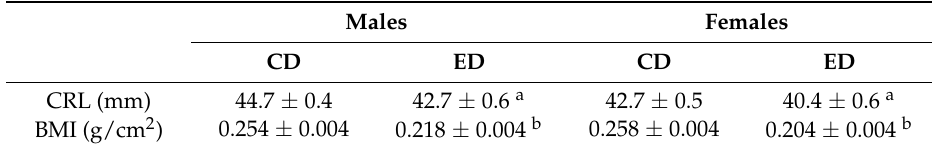
Figure 2. Relationship between fetal outcome and maternal plasma levels of ( A ) Arachidonic acid (ARA) and ( B ) Docosahexaenoic acid (DHA) in experimental diet fed dams. NG, Normal growth; IUGR, Intrauterine growth restriction; and FR, Fetal reabsorption. Data show mean ± SEM. Between parenthesis, the sample size is shown. ANOVA. a p < 0.05 FR versus NG; b and p < 0.05 FR versus IUGR. Average fetal body weight and length were significantly smaller in ED compared with CD fetuses, both in males and in females (Figure 3A,B). Fetal crown-rump-length (CRL) and body mass index (BMI) were smaller in ED compared to CD fetuses, both in males and females (Table 1). Considering IUGR individuals below the 3rd percentile, the percentage of IUGR was larger in ED offspring (40.4% of males and 50.0% of females) than in the CD group (2.6% of males and 2.9% of females). Table 1. Fetal anthropometric